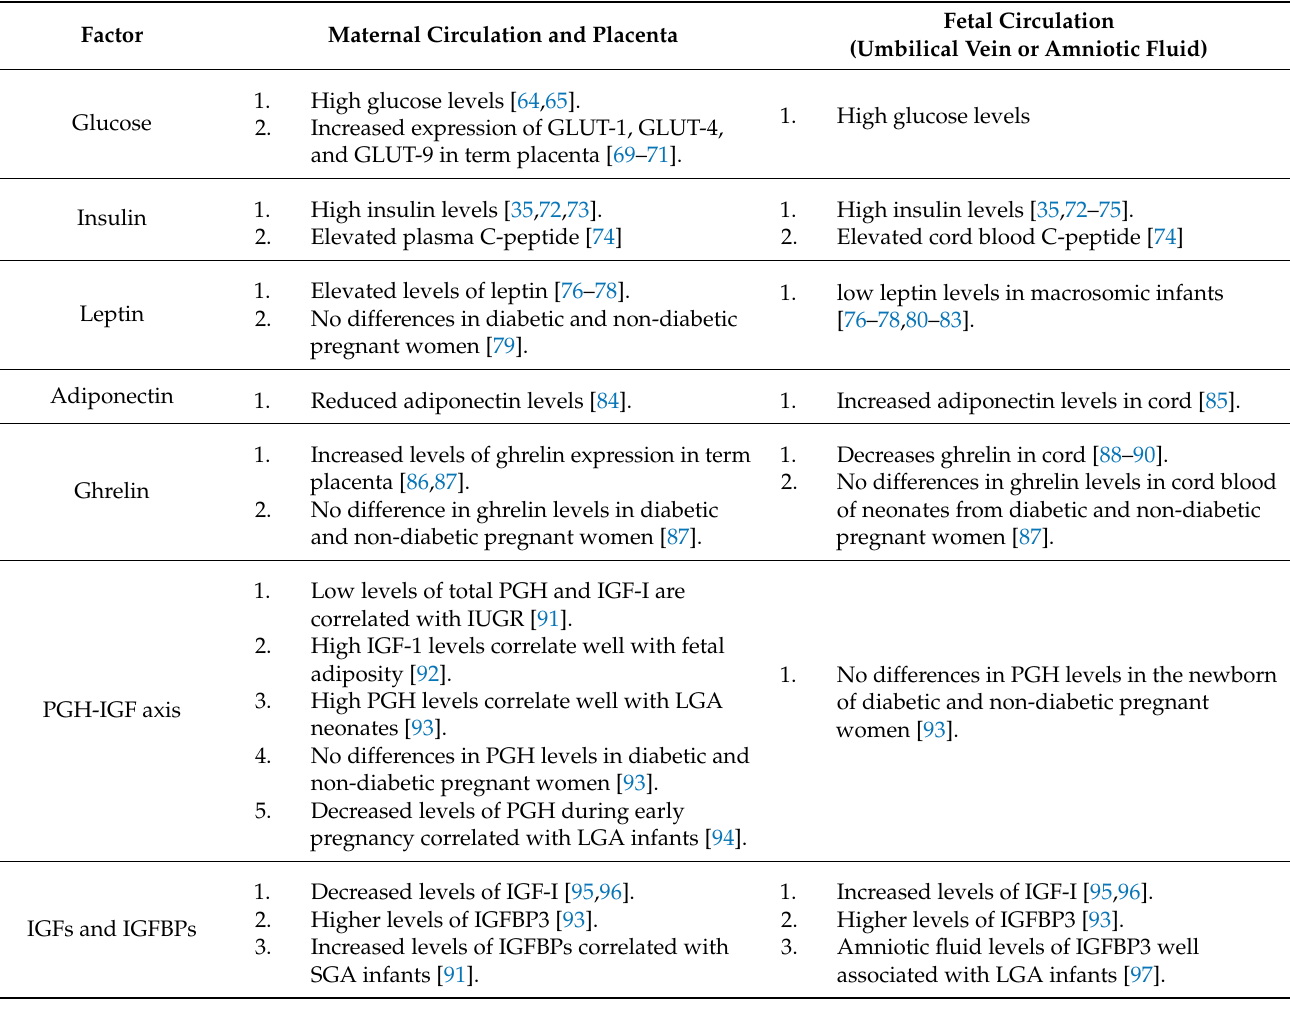
Table 2. Factors contributing to fetal macrosomia in diabetic